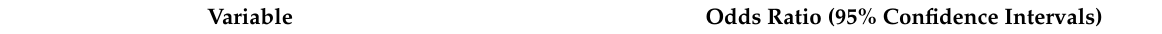
Factors Independently Related to the Availability of a Total Cholesterol Measurement During Hospitalization